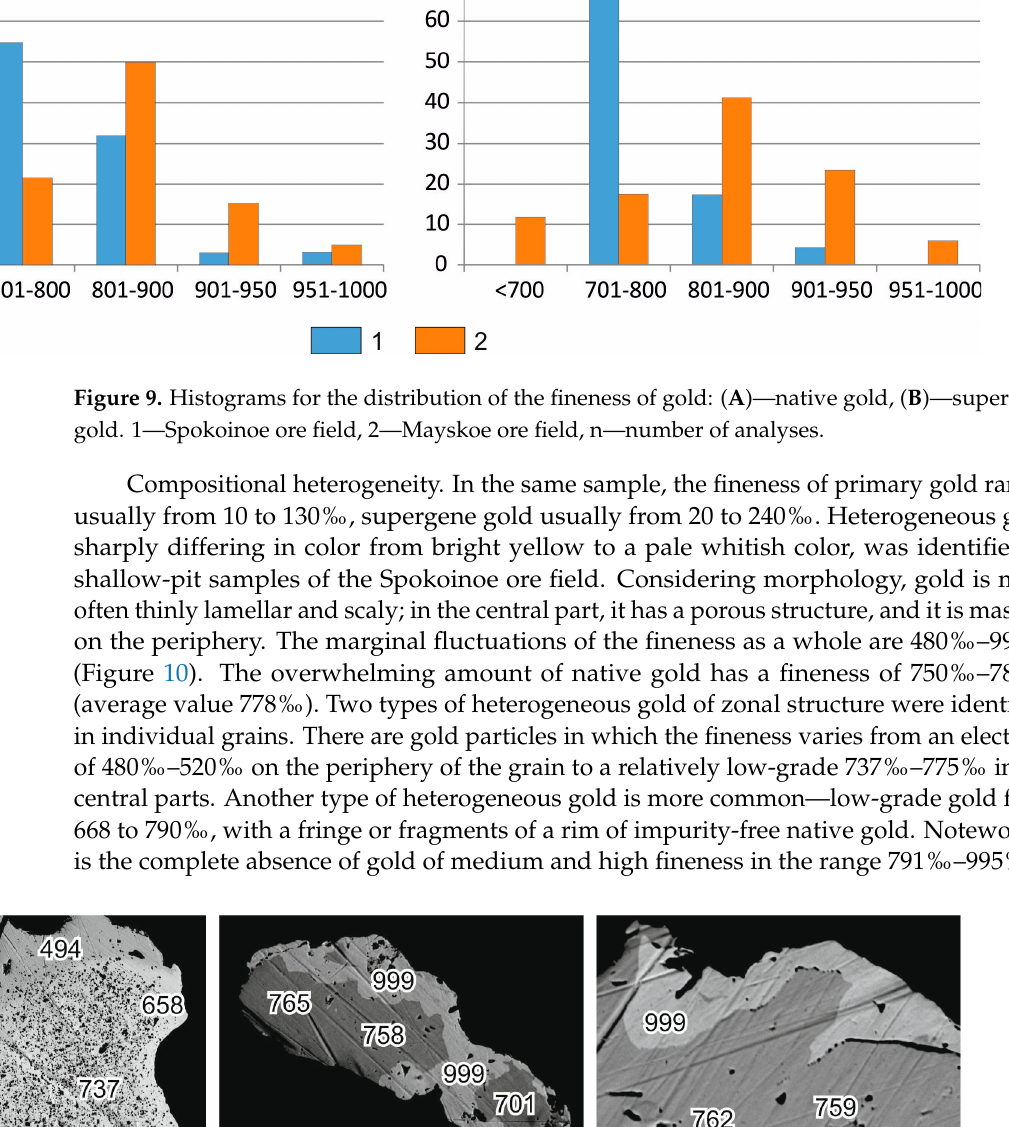
Figure 9. Histograms for the distribution of the fi neness of gold: ( A )—native gold, ( B )—supergene gold. 1—Spokoinoe ore fi eld, 2—Mayskoe ore fi eld, n—number of analyses.